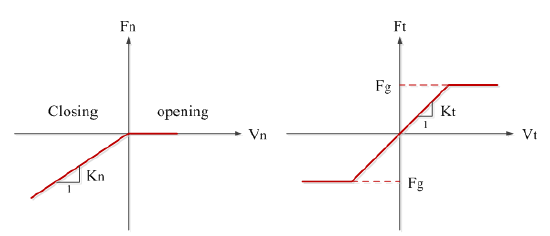
Figure 2. Force-deformation relations for